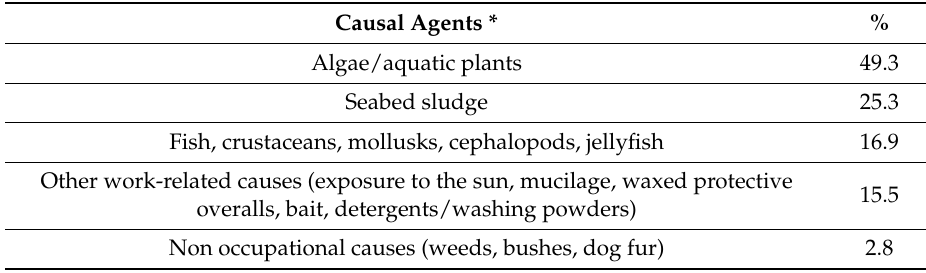
Table 4. Frequency of causes of onset of transient itchy wheals referred by the fishermen who manifested these lesions ( N =